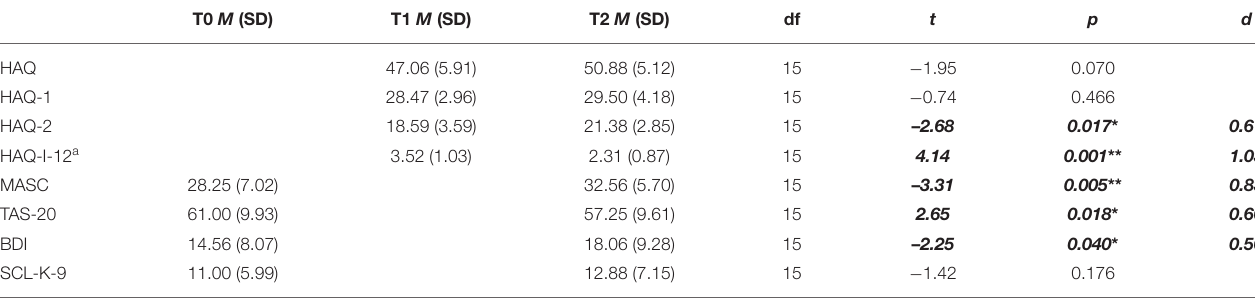
TABLE 2 | Measures of acceptance and effectiveness of